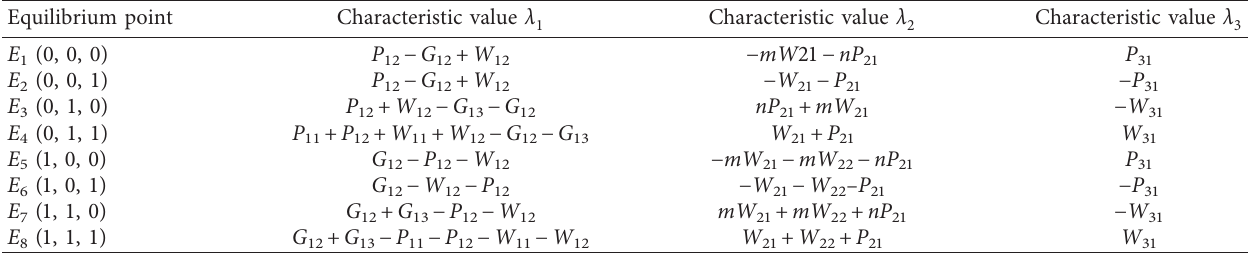
Table 3: Eigenvalues of the Jacobian matrix corresponding to each equilibrium point.